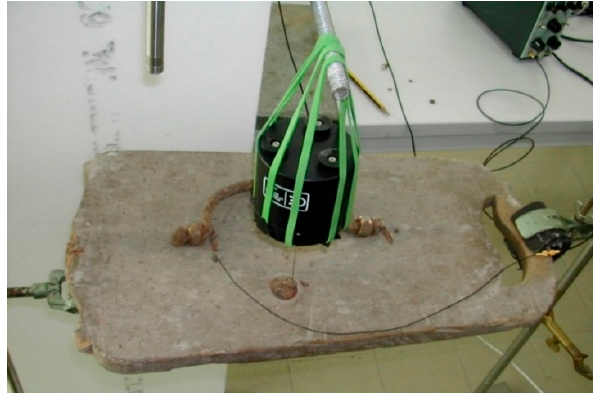
Figure 3. The measurements on the carabattola.